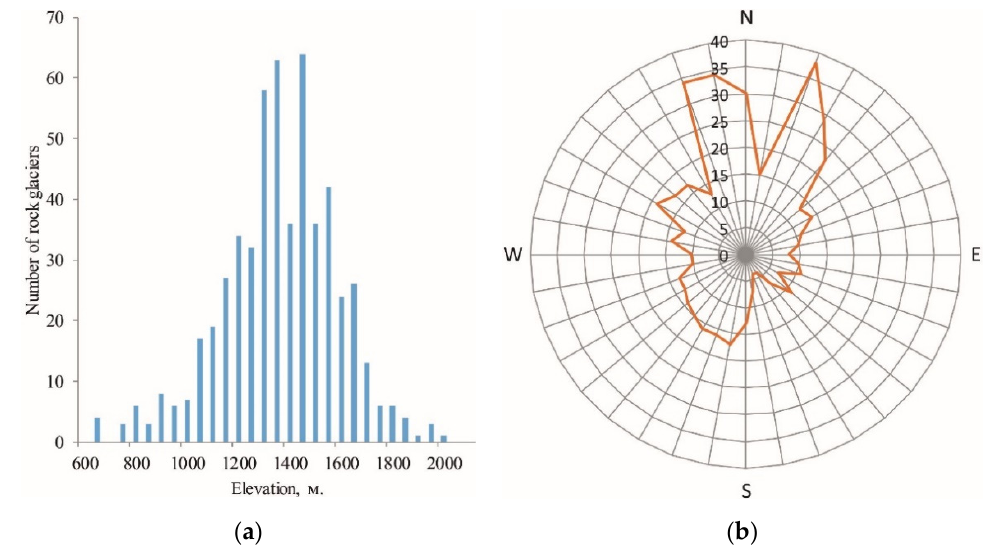
Figure 7. Distribution of mean absolute altitudes ( a ) and exposure of slopes ( b ) and rock glaciers of the Verkhoyansk Range.